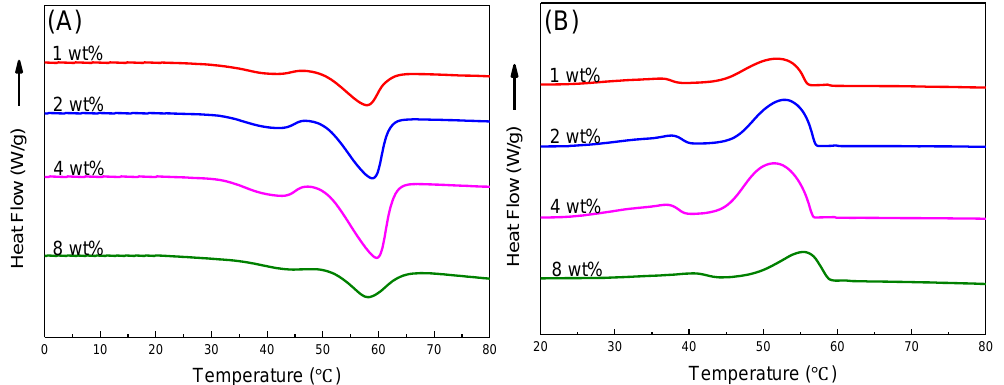
Figure 5. DSC curves of heating ( A ) and cooling ( B ) processes of microcapsules prepared with different amounts of sodium chloride. The heating and cooling rates are 10 °C/min